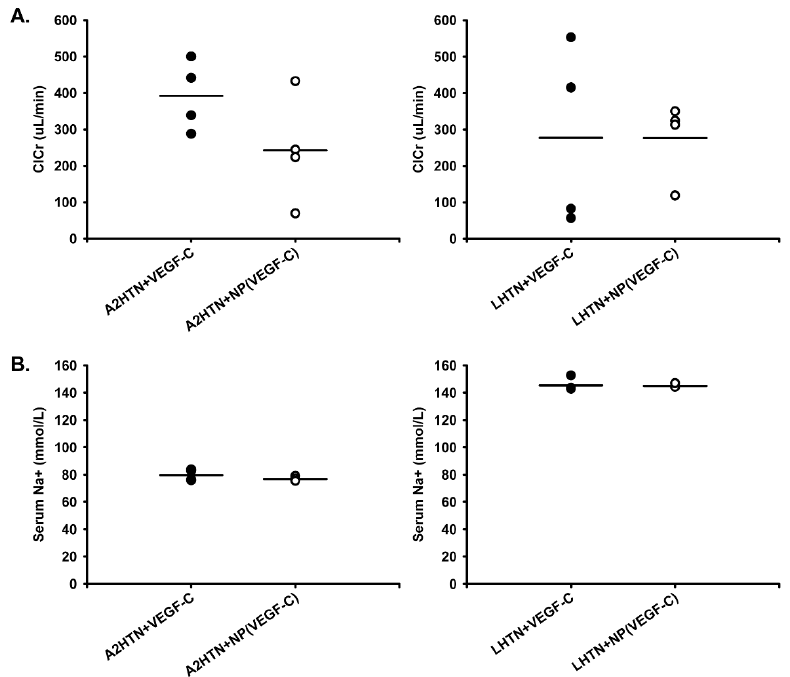
Figure 4. Treatment with VEGF-C in NPs had no effect on creatinine clearance or serum sodium levels. ( A ) Creatinine clearance and ( B ) serum sodium in male and female A2HTN and LHTN mice treated every 3 days with VEGF-C in NPs or VEGF-C alone. Results are expressed as mean (n = 4 per group) and statistical analyses were performed with Student’s t -test. * p < 0.05 vs. VEGF-C-alone treated mice.